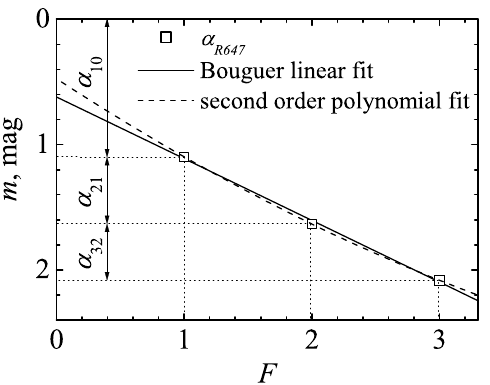
Fig. 4. Dependence of observed mag- nitudes on air mass, when the extra- atmospheric magnitude is 0.0 mag, the transmittance of the atmosphere is calcu- lated for the Mol˙etai Observatory with al- titude h = 220 m and a mean thickness of the ozone layer of T = 3 mm. The atmosphere is without aerosols and a star of the O V spectral type is observed with in the WET R647 passband. The differ- ence Δ α 0 = α 01 − α 12 gives the error of the extra-atmospheric magnitude when it is estimated by the Bouguer method us- ing the observed magnitudes at 1 and 2 air